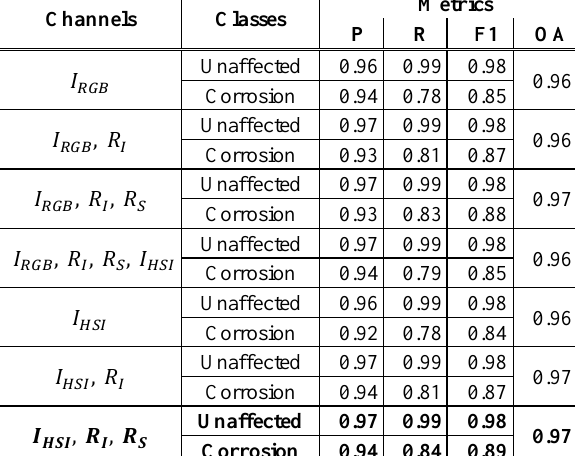
Table 2. Aggregation of all non-corrosion classes to one class and evaluation of the resulting classes unaffected and